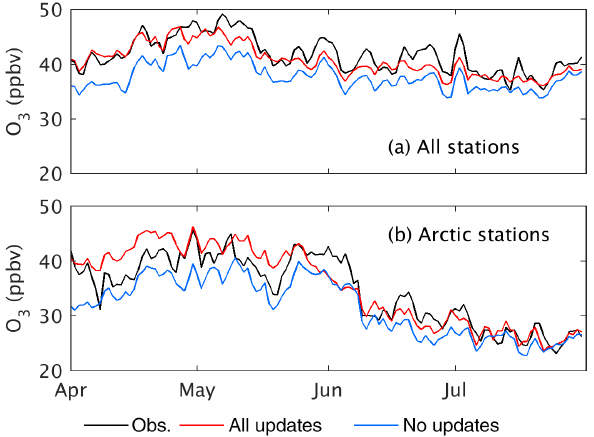
Figure 9. Comparison between daily averaged surface ozone mea- surements (black) and WRF-Chem results (red, ALL_UPDATES; blue, NO_UPDATES) (a) averaged over all stations within the do- main (228 stations) and (b) averaged over Arctic stations only (lat- itude > 60 ◦ N, 17 out of 228